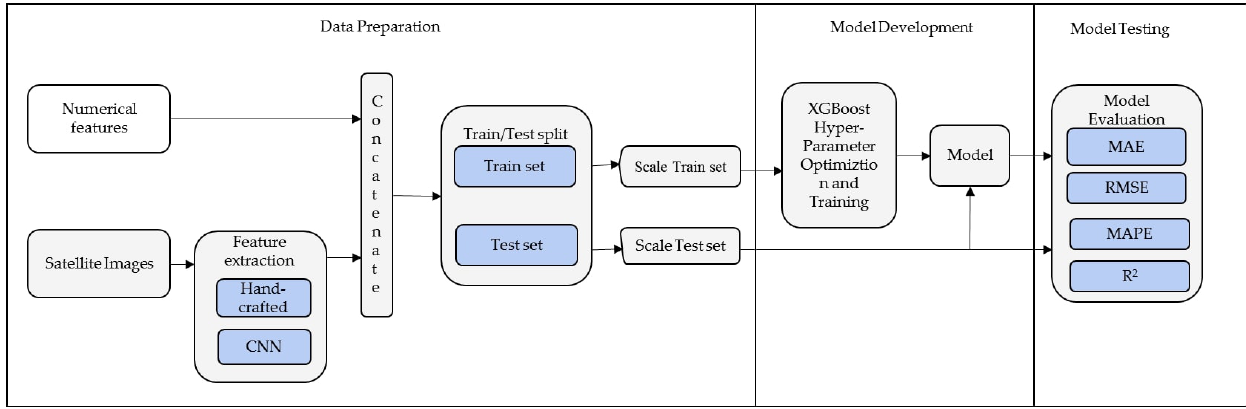
Figure 2. Model development process with three main phases; data preparation, model development, and model